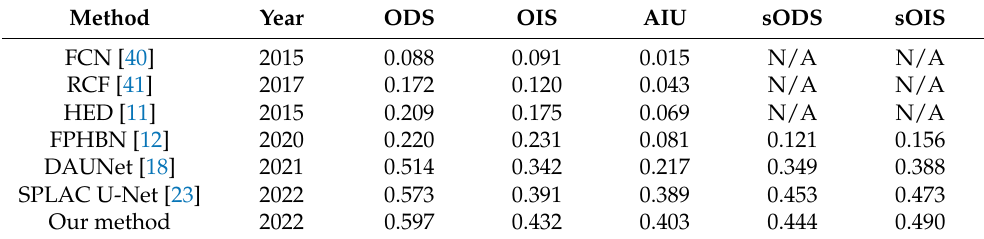
Table 6. Segmentation performance comparison results on GAPs384 dataset.